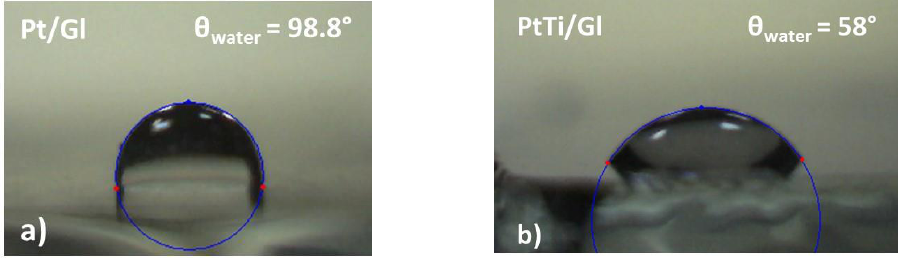
Figure 8. Droplet images and the calculated contact angles by SEE system software using water on a glass substrate: ( a ) of Pt and ( b ) of PtTi thin films.